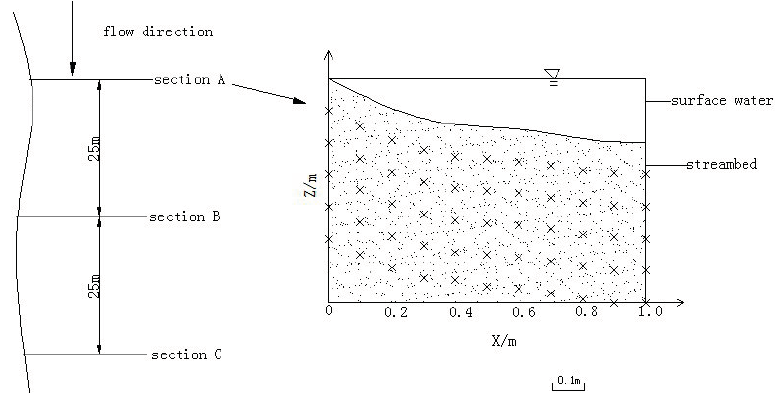
Fig. 2 Location of the test sections and the distribution of sampling points.